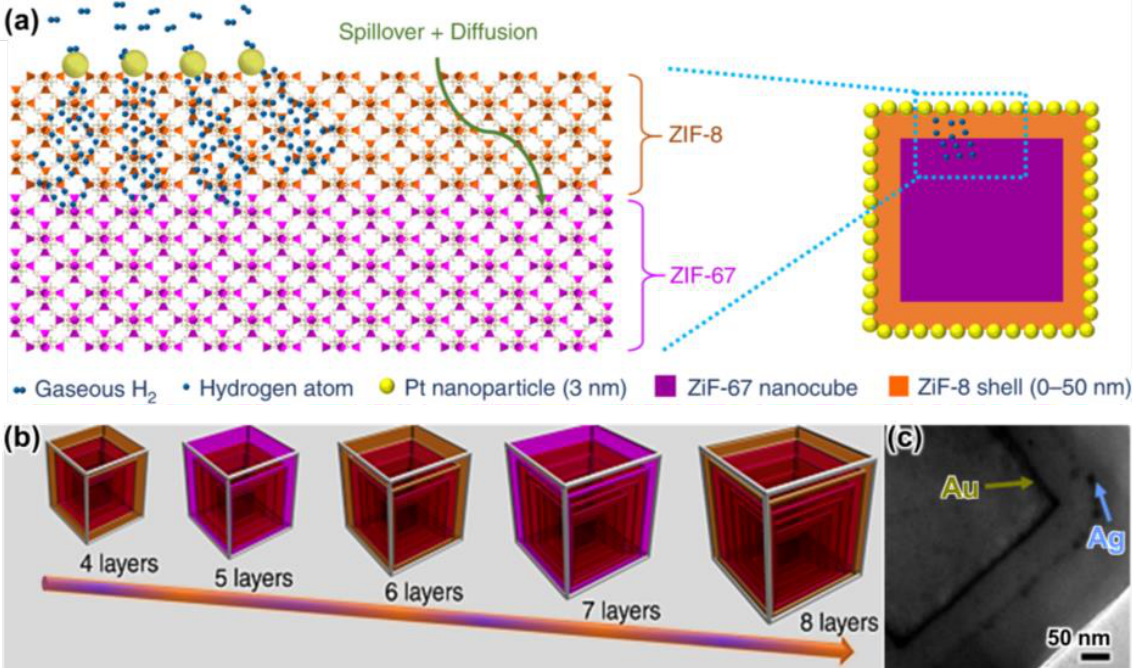
Figure 6. ( a ) Schematic illustration of the hydrogen spillover and diffusion mechanism on Matryoshka-type ZIFs, ( b ) designs of Matryoshka-type ZIFs, and ( c ) TEM image of metal loaded-ZIF for hydrogen spillover. Reproduced from ref. [78]; copyright (2018) with permission from Nature Re- search.